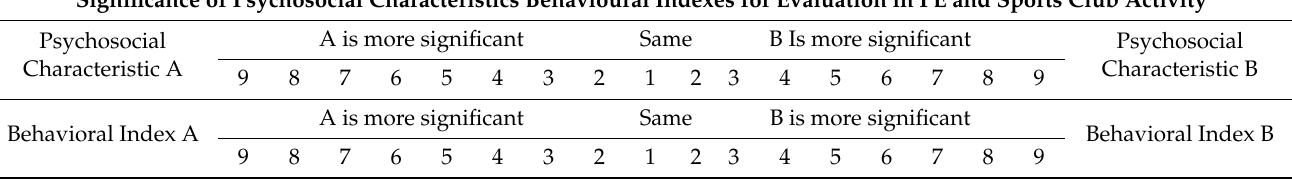
Table 2. Comparative Table for Psychosocial Characteristics and Behavioral